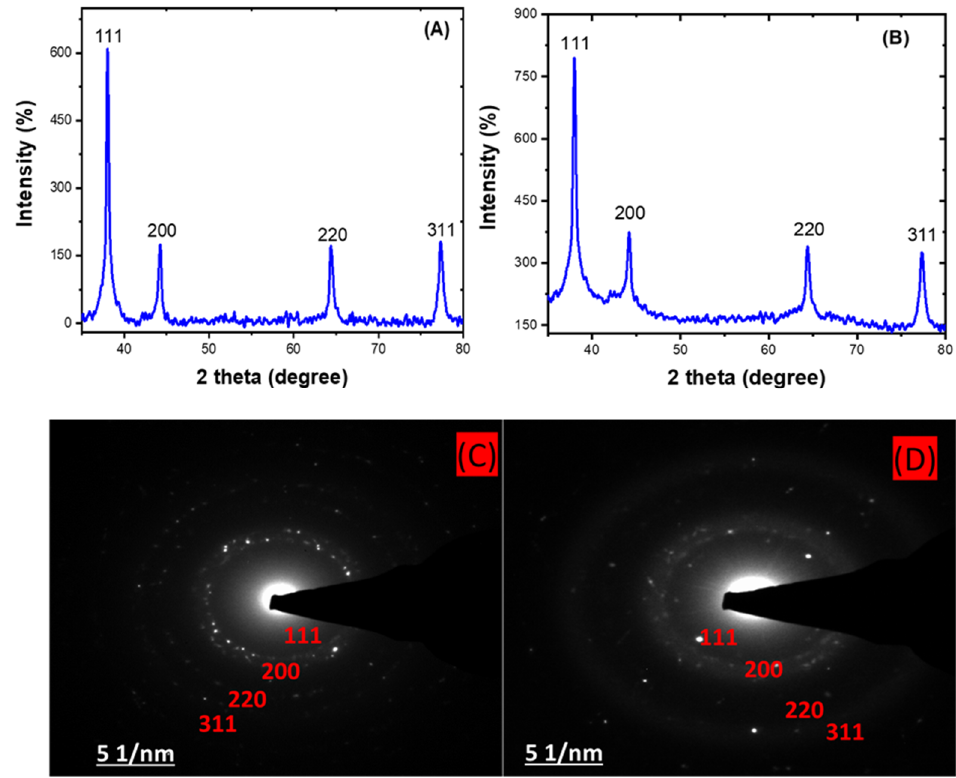
Figure 4. XRD patterns showing the diffraction peaks of HE-AgNPs ( A ) and HP-AgNPs ( B ). A se- lected area electron diffraction of HE-AgNPs ( C ) and HP-AgNPs ( D ) represented their crystallinity degree.